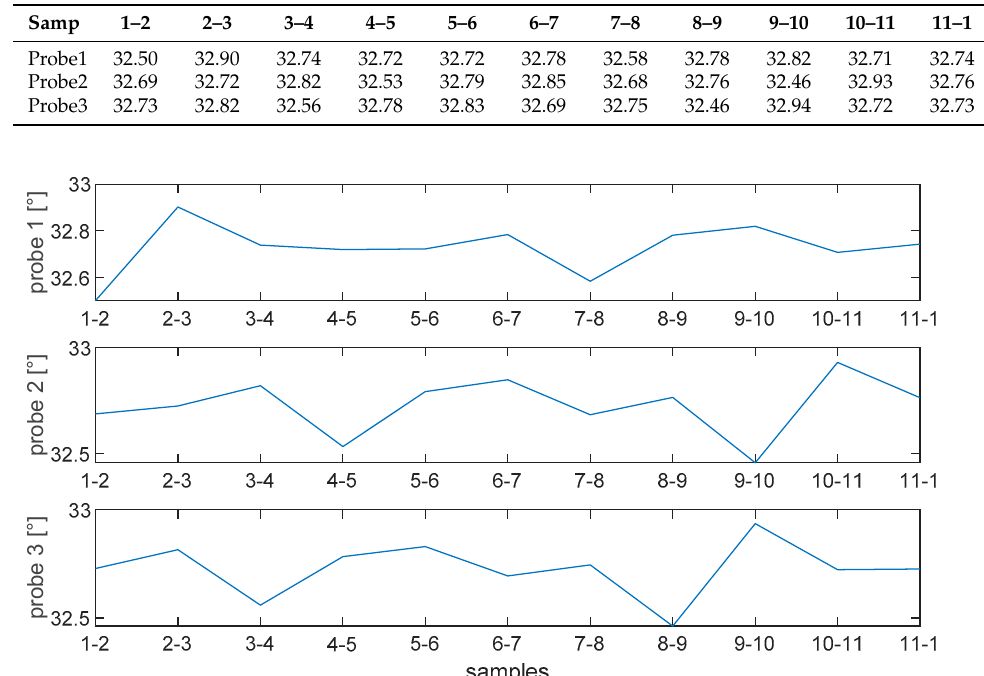
Figure 4. Precise angle (°) between consecutive samples estimated from the three different signals.